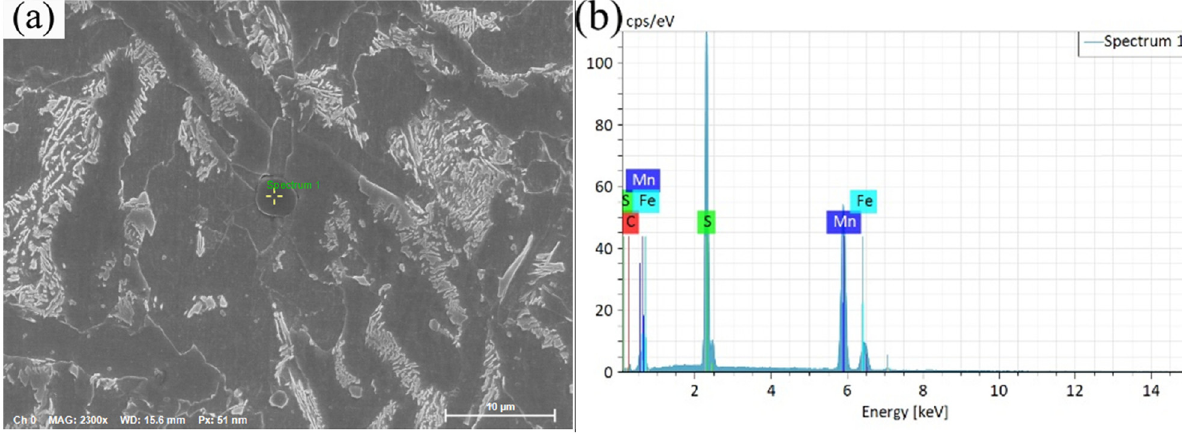
Figure 3: Morphology ( a ) and EDS results ( b ) of MnS in as - cast steel.